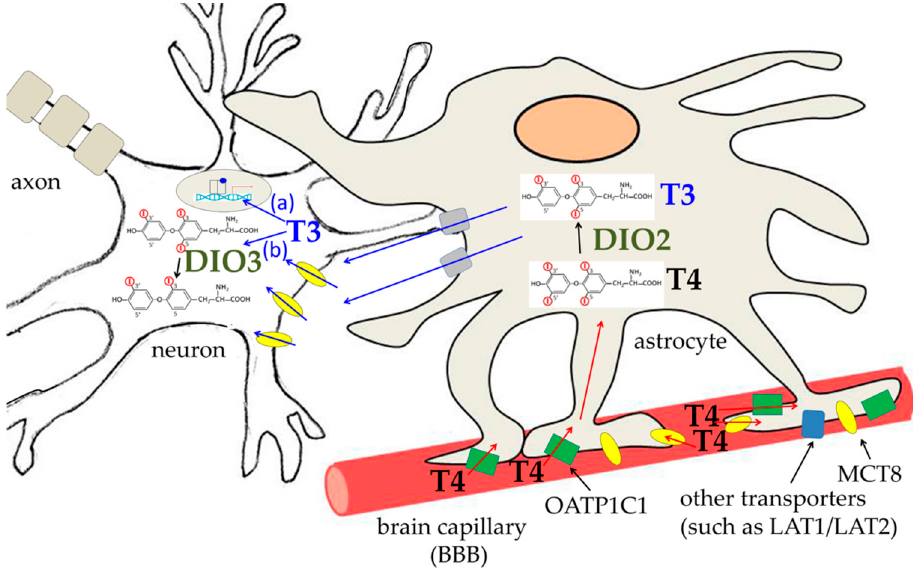
Figure 2. Trafficking of THs to the brain across the blood–brain barrier (BBB). T4 is the main hormone crossing the BBB. It then enters astrocytes through both OATP1C1 (green rectangles) and MCT8 (yellow ovals) transporters, as well as through other transporters (blue rectangles), such as LAT1/LAT2. T3 is much less represented in the blood; a few molecules can perhaps reach astrocytes through MCT8. Once in the astrocytes, T4 is converted to T3 by deiodinase 2 (DIO2). T3 can then exit astrocytes through transporters that are not well characterized (grey rectangles) and enter neurons through MCT8. In the neuron, T3 can enter the nucleus and bind its nuclear receptors (pathway a) or it can be catabolized by DIO3 (pathway b).